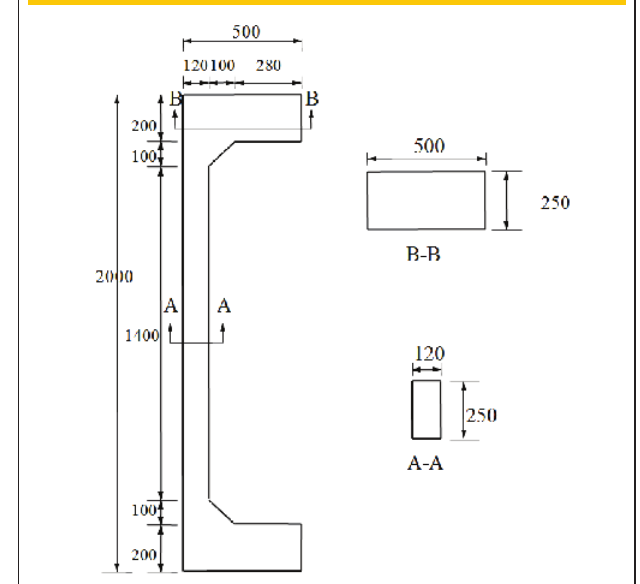
Figure 1 – Dimensions of original columns (mm)